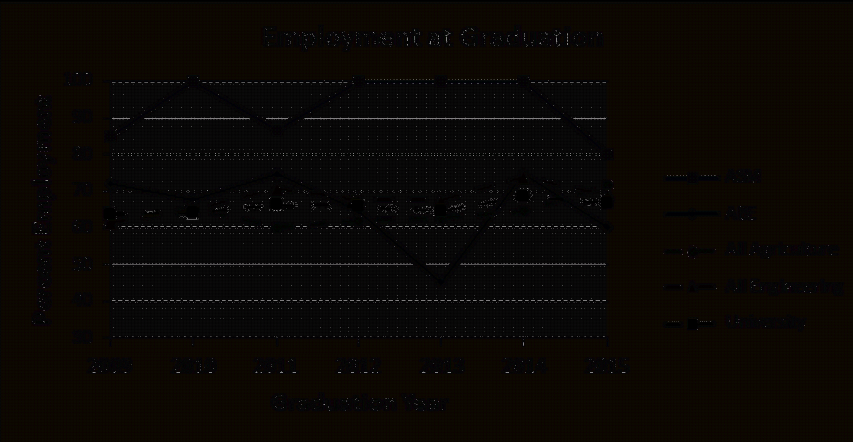
Fig. 1. Comparison of Professional Employment at